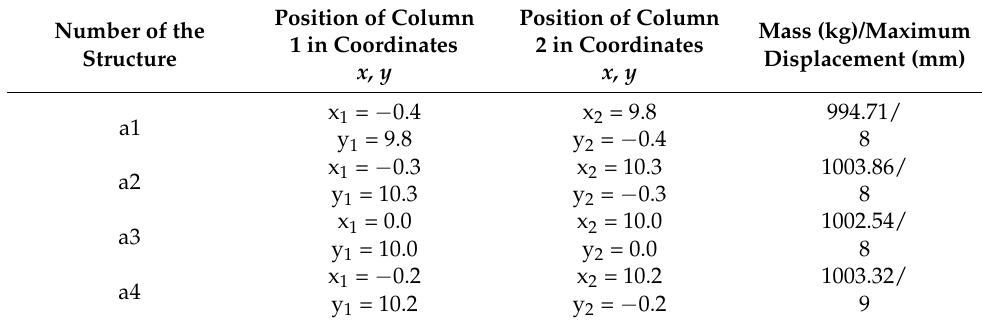
Table 1. The simulation results for the hyperbolic paraboloid structure with a grid pattern of type a (the grid split along shorter diagonals).